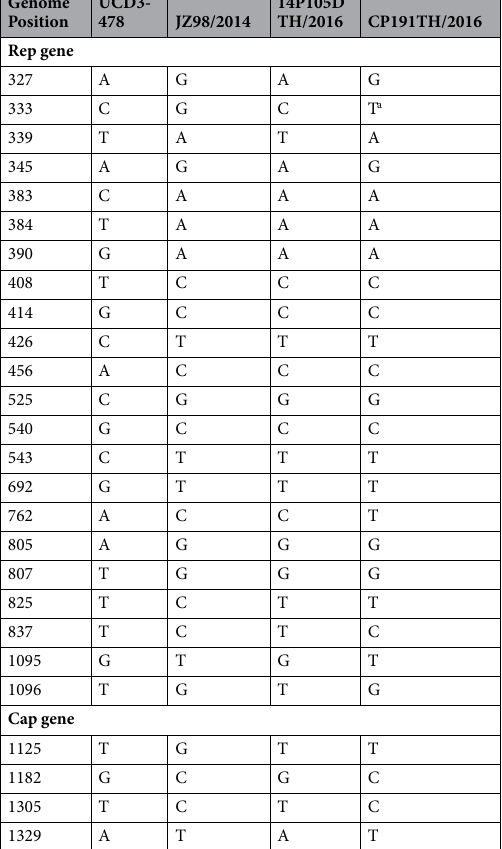
Table 2. Comparison of nucleotide marker positions between recombinant CanineCV 14P105D TH/2016 and its parenteral CanineCV strains. a Specific nucleotide mutation detected in CanineCV CP191 TH/2016